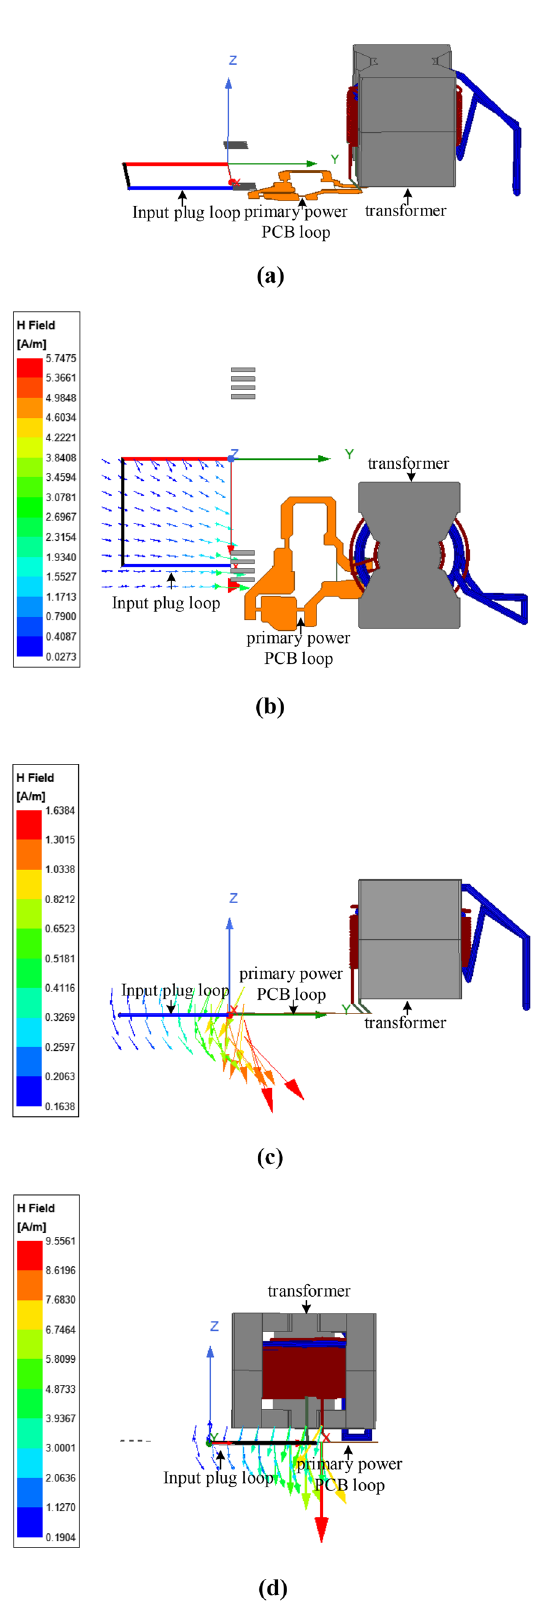
Figure 22. Distribution of magnetic field generated by primary power PCB loop and transformer: ( a ) schematic diagram of magnetic field coupling simulation; ( b ) magnetic field distribution from z-direction; ( c ) magnetic field distribution from x-direction; ( d ) magnetic field distribution from